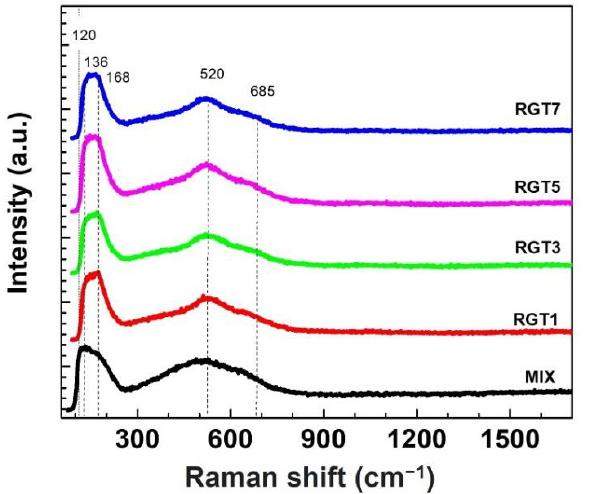
Figure 3. ( a – e ) AFM images of MIX, RGT1, RGT3, RGT5, and RGT7, respectively. ( f ) Relationship between the grain size and gas-timing N 2 turn-on time (black circles) and the roughness and gas- timing N 2 turn-on time (blue squares).